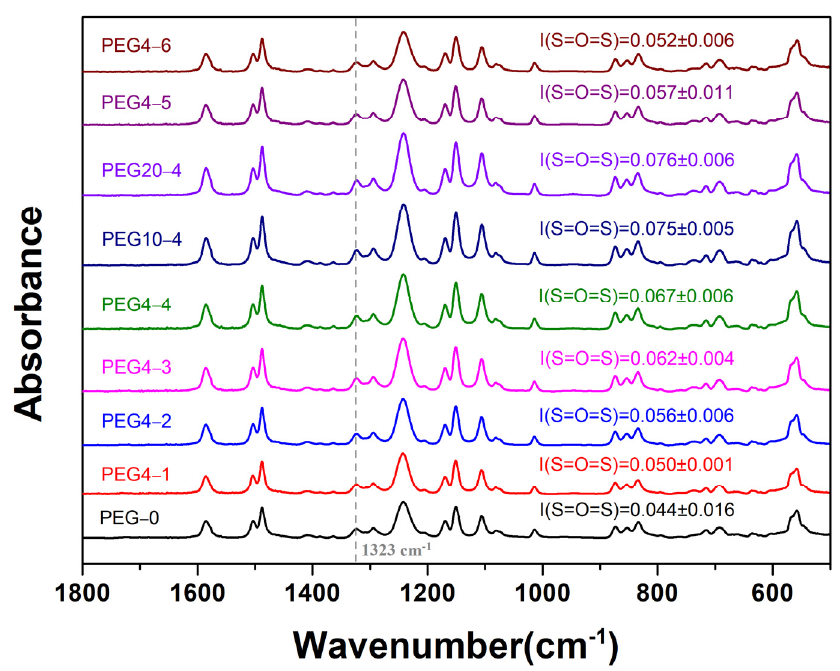
Figure 1. FTIR spectra of PSU/PEG substrate surface.